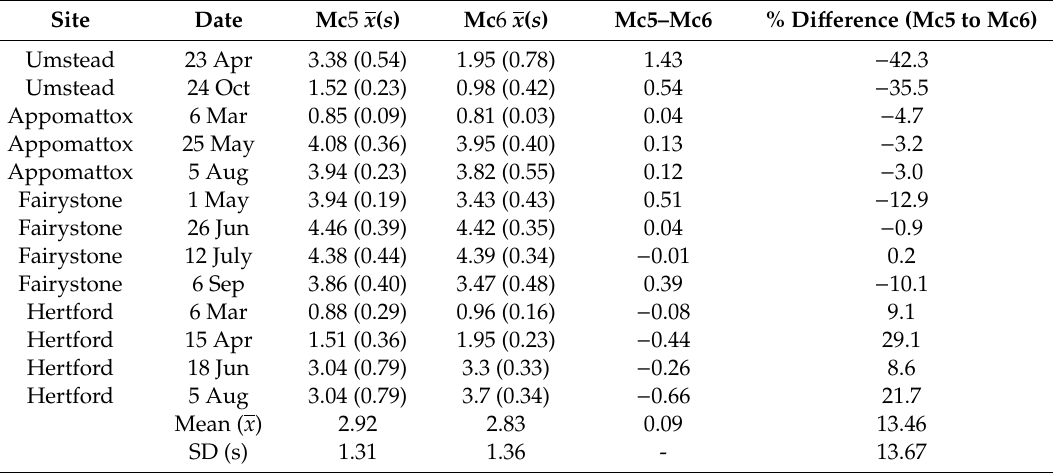
Figure 7. Data quality di ff erences for MODIS Mc5 and Mc6 data over all four research sites over 13 dates: ( A ) Appomattox / Umstead, ( B ) Fairystone, ( C ) Hertford. * RT—radiative transfer. Table 7. Mean LAI di ff erences across each 3 × 3 grid of 12.0 km grid cells per site per